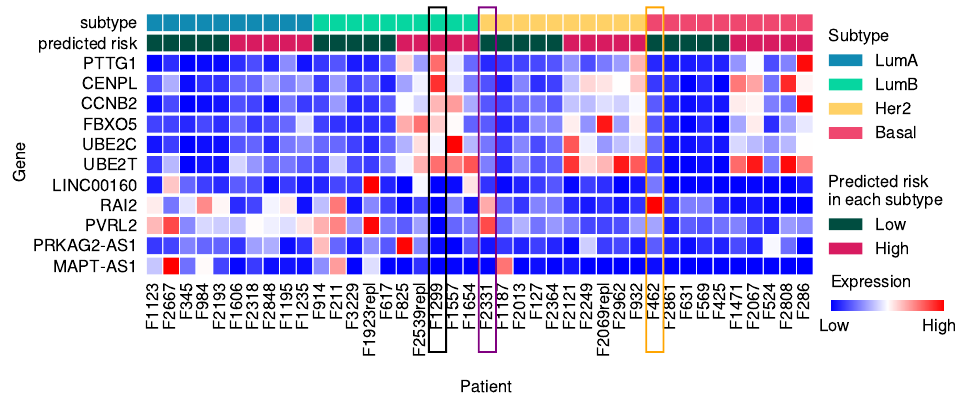
Figure 6. Expression patterns of frequently selected genes for the five patients with the lowest risk scores and the five patients with the highest risk scores within each subtype in SCAN-B data set. The amounts of gene expression were normalized for each gene within the entire data set. Among Basal patients, the F462 patient had the smallest risk score and is highlighted with an orange box. F462 had significantly high expression of the RAI2 gene. Among Her2 patients, the F2331 patient had the smallest risk score and is highlighted in a purple box. F2331 had relatively high expression of the RAI2 gene and PVRL2 gene. F1299 patient in the high-risk group of LumB is highlighted with a black box. F1299 showed high expression levels of genes that were related to worse prognosis with high expression and low expression levels of genes that were related to worse prognosis with low expression.